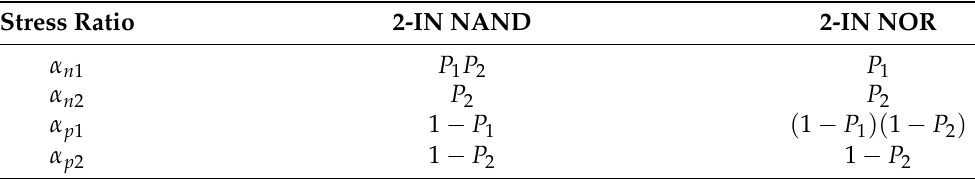
Table 2. Stress table for 2-in basic gates as a function of the input signal probabilities. Stress Ratio 2-IN NAND 2-IN NOR α n 1 P 1 P 2 P 1 α n 2 P 2 P 2 α p 1